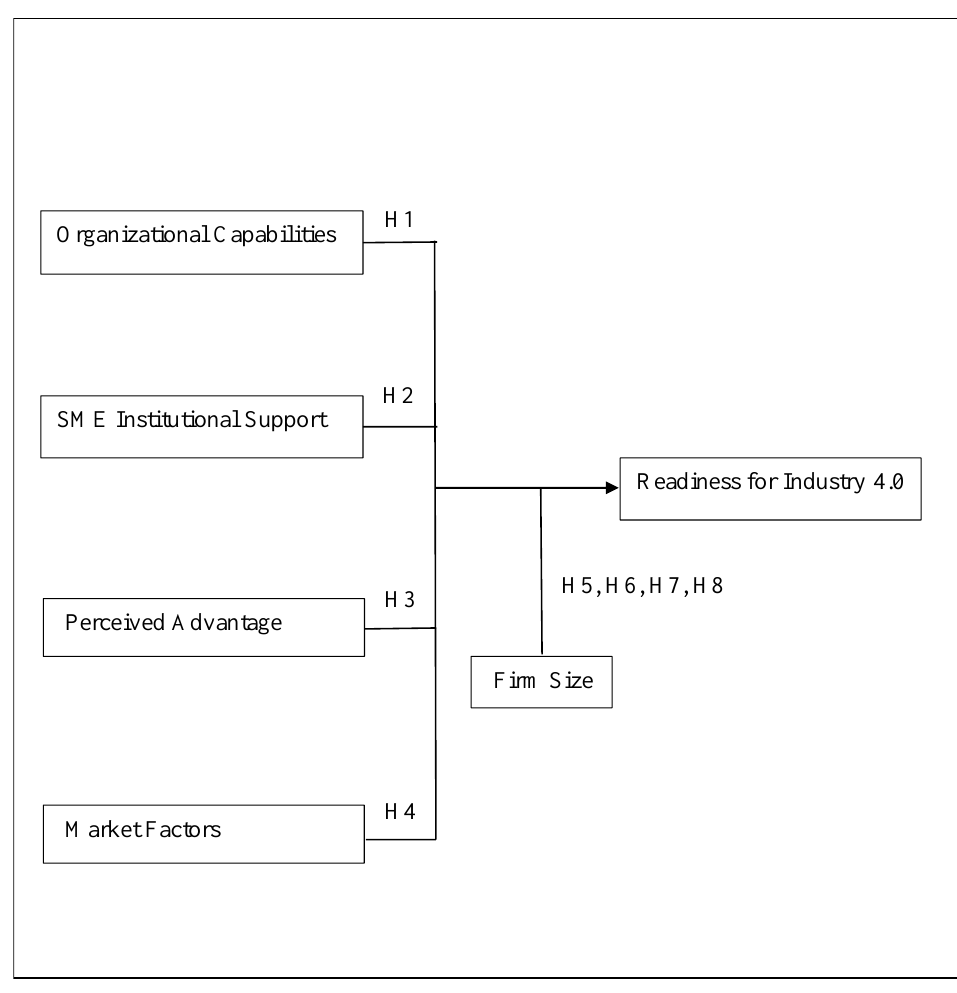
Figure 1. Theoretical framework.